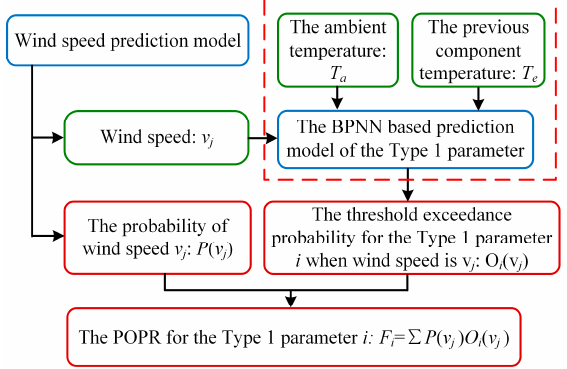
Figure 4. The calculation method of the probabilities of the operation of the protection relays (POPR) for the environmentally sensitive parameters.